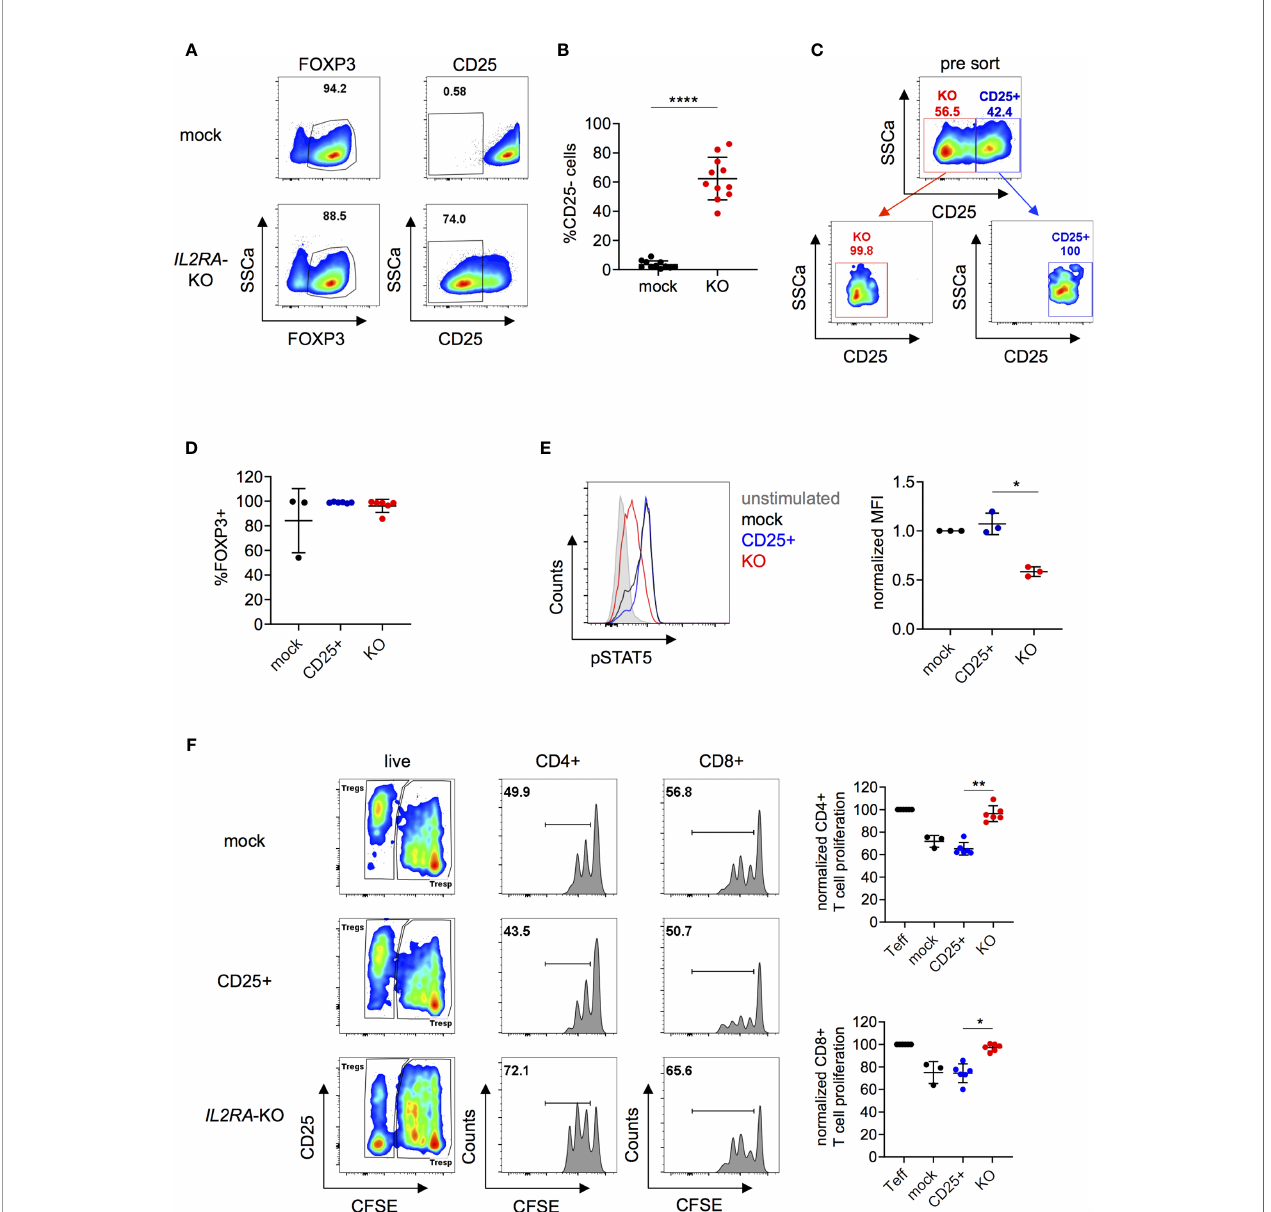
FIGURE 4 | Knock-out of IL2RA in human Tregs impairs suppressive capacity and IL-2-mediated signaling. Human Tregs were cultured in vitro for 7 days prior gene editing (following protocol described in Figure 1A ). (A) FOXP3 and CD25 expression were analyzed in mock and IL2RA -KO Tregs that were harvested 4 days after RNP nucleofection. FOXP3 plots are pre-gated on living cells and CD25 plots are pre-gated on living FOXP3 + cells. Data are from one representative experiment. (B) CD25 expression was studied in mock and IL2RA-KO Tregs 4 to 7 days after nucleofection. n = 11 independent donors. Error bars represent mean ± SD. (C) RNP-transfected cells were FACS-sorted for CD25 expression and as living (PI - ) CD4 + CD127 - cells. Top panel displays pre-sorted cells and bottom panels represent re-analysis post sorting. (D) FOXP3 expression after CD25-sorting in mock (n = 3), CD25 + (n = 6) and IL2RA -KO (n = 6) Tregs. Error bars represent mean ± SD. (E) STAT5 phosphorylation was studied in CRISPR-edited Tregs. FACS plot of one representative experiment (left panel) and combined data of three independent donors (right panel). Error bars represent mean ± SD. MFI is normalized over IL-2-stimulated mock. (F) Suppressive capacity of IL2RA -KO Tregs was measured by their ability to suppress T cell proliferation in vitro (ratio 1:2). Left panels show FACS plots of one representative donor. Cells are pre-gated for viability (all columns) and CD4 or CD8 expression (middle and right column, respectively). Right panels show CD4 + and CD8 + T cell proliferation, displayed by dilution of the cell proliferation dye CFSE. Proliferation is normalized over T cell proliferation in the absence of Tregs (n = 3-6 independent donors). Error bars represent mean ± SD. Signi fi cance was calculated by two-tailed paired t test (B) , Kruskal-Wallis test (D, F) or one-way ANOVA (E) . *p ≤ 0.05, **p ≤ 0.01. ****p ≤